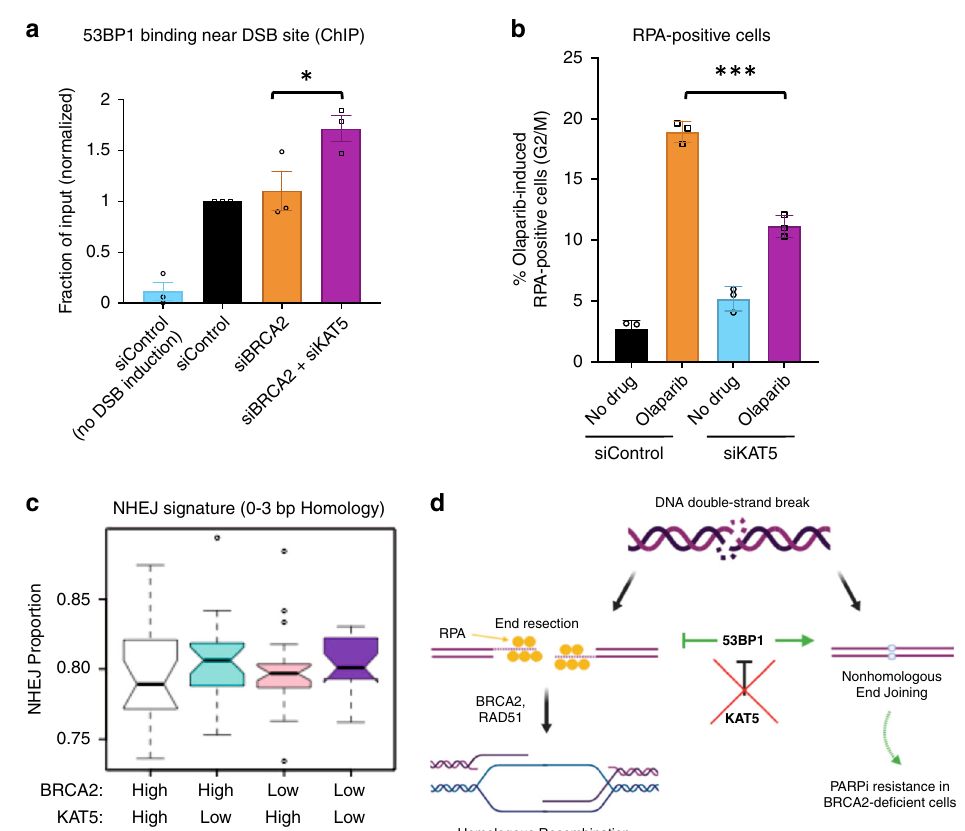
Fig. 6 Functional consequences of KAT5 depletion. a Depletion of KAT5 leads to increased recruitment of 53BP1 near the site of the double-strand break in BRCA2-depleted U2OS-DSB reporter cells. DSBs were generated at a speci fi c genomic locus through induction of expression of LacI-FokI nuclease. Then, chromatin immunoprecipitation was performed with an antibody against 53BP1 and qPCR was performed using primers for the DSB site. The averages of three experiments are shown, with standard error of the mean as error bars. Asterisks indicate statistical signi fi cance ( t -test, two-tailed, paired). b KAT5 loss leads to a reduction in olaparib-induced end resection as measured by quanti fi cation of RPA-positive cells. Cells were treated with 10 μ M olaparib for 12 h before being harvested for fl ow cytometry experiments using an RPA antibody. Representative gating of these experiments is shown in Supplementary Fig. 12. The averages of three experiments are shown, with standard deviations as error bars. Asterisks indicate statistical signi fi cance ( t -test, two-tailed, unequal variance). c Bioinformatic analysis of the OV-AU dataset reveals that KAT5 low tumors show increased NHEJ signature at structural variations breakpoints, as compared to KAT5 high tumors, in both BRCA2 high and BRCA2 low backgrounds. The 93 samples in the cohort were distributed into four categories based on combinatorial high (above median) and low (below median) expression of BRCA2 and KAT5. In the box plots, lower and upper hinges correspond to the fi rst and third quartiles; upper and lower whiskers extend to 1.5 × interquartile range; the line in the box indicates the median; outlier data are shown as points. d Proposed model for resistance caused by KAT5 depletion. In BRCA2-pro fi cient cells, homologous recombination is the most accurate mechanism of double-strand break repair. However, this pathway is not functional in BRCA2-de fi cient cells. KAT5 depletion increases 53BP1 binding at the double-strand break in BRCA2-de fi cient cells, preventing the break from proceeding down the dead-end process of HR and instead directs it towards repair by NHEJ. Source data are provided as a Source Data fi